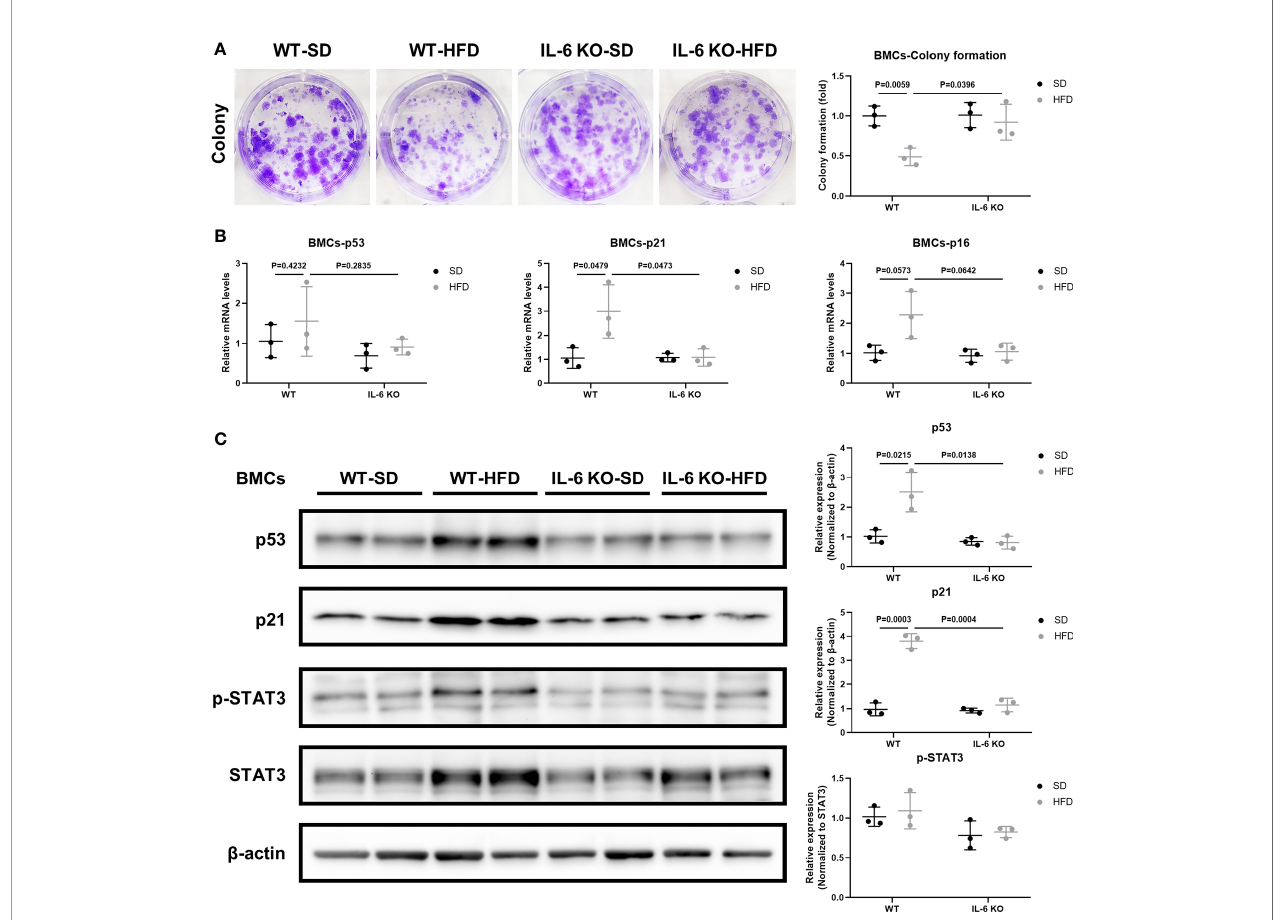
FIGURE 5 | IL-6 KO attenuated senescence of BMCs in HFD-induced bone loss. (A) Representative images for colony formation of bone marrow cells (BMCs) from WT and IL-6 KO mice after SD or HFD treatment. The number of colonies per well was counted and calculated (right panel). (B) The mRNA levels of typical aging markers (p53, p21, p16) in BMCs from WT and IL-6 KO mice after SD or HFD. (C) Western blot analysis of indicated proteins (p53, p21, p-STAT3, STAT3, b -actin) in BMCs of WT and IL-6 KO mice fed with SD or HFD for 12 weeks. The expression of p53 and p21 was normalized against b -actin, and the expression of p-STAT3 was normalized against STAT3. Quantitative analysis with Image J software was shown on the right panel. Data were expressed as mean ±